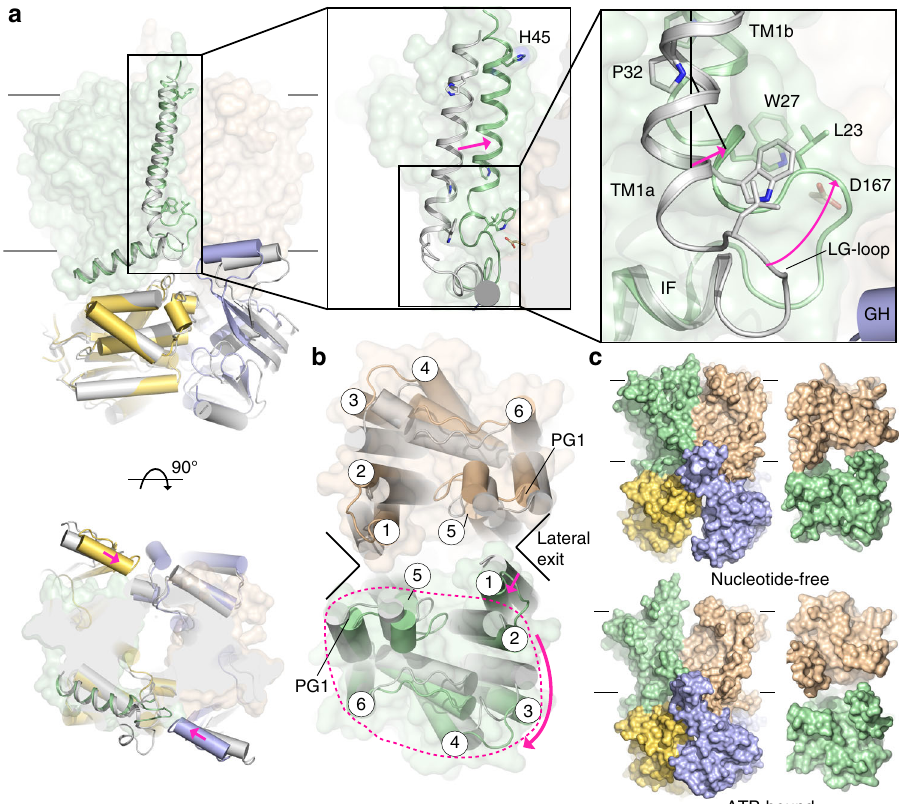
Fig. 5 ATP-induced conformational changes of WzmWzt. a The Wzm and Wzt subunits of the nucleotide-free state (shown in gray) were individually structurally aligned with the corresponding subunits in the ATP-bound conformation. For Wzt, alignment was based on the helical subdomain (residues 82 – 192) and for Wzm, on TM helices 2 – 6 by secondary structure matching in Coot 52 . b Global alignment based on the NBD-dimer of the nucleotide-free (gray) and ATP-bound states. Shown is a periplasmic view of the Wzm protomers. c Surface representations of the nucleotide-free and ATP-bound WzmWzt conformations. In all panels, Wzt and Wzm are shown in yellow/blue and green/wheat,